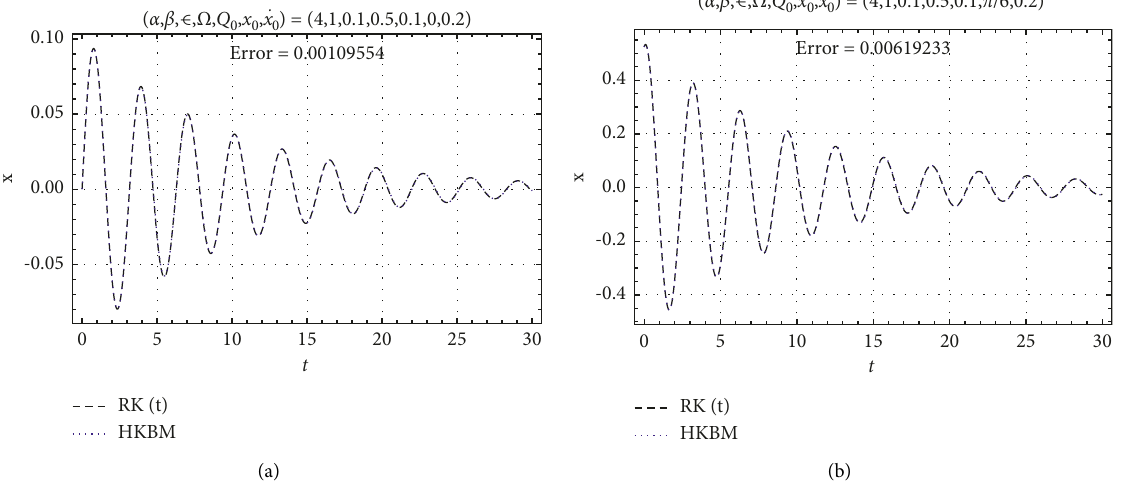
Figure 6: Both HKBM first-order approximate solution (42) and RK numerical simulation are plotted against different values of the initial angle x 0 .